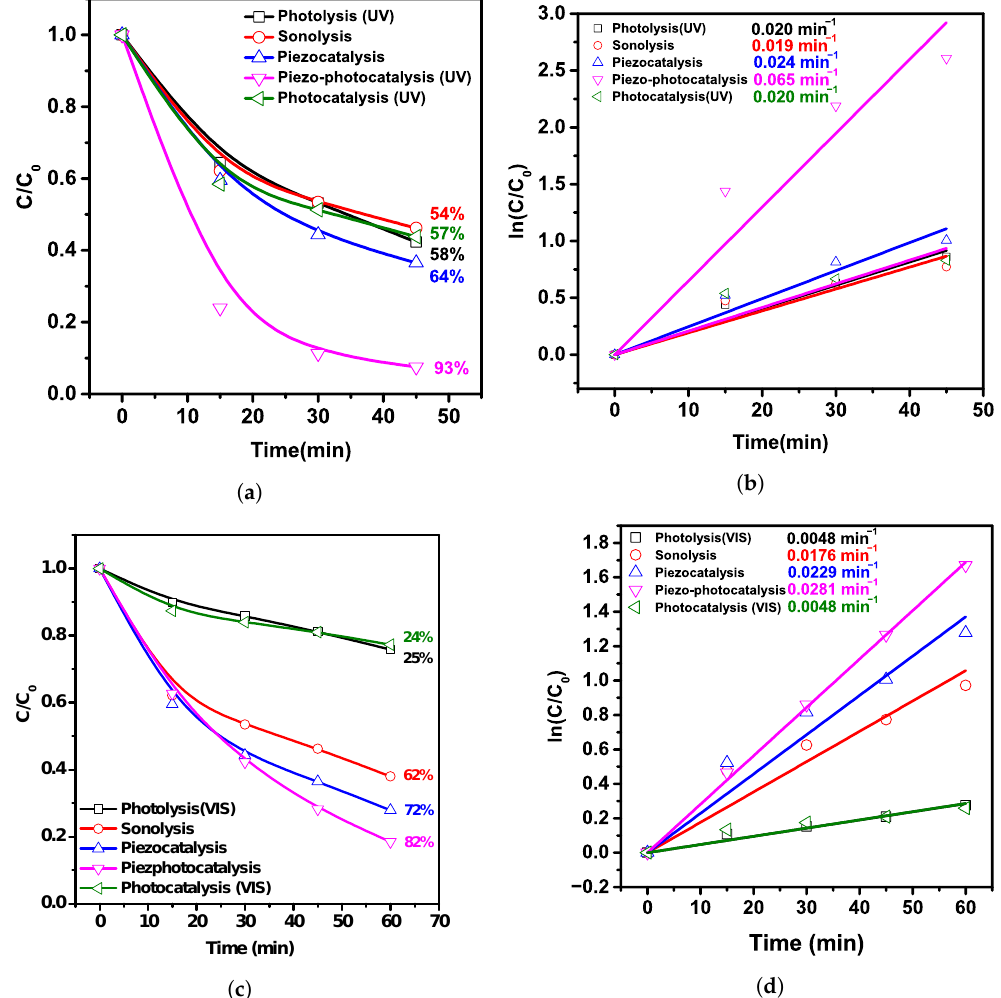
Figure 6. ( a ) MB degradation curves (1mgL − 1 , 20 mL) and ( b ) time dependence of ln( C / C 0 ) for PVDF/BFO nanofibers under UV irradiation; ( c ) MB degradation curves (1mgL − 1 , 20 mL) and ( d ) time dependence of ln( C / C 0 ) for PVDF/BFO nanofibers under visible